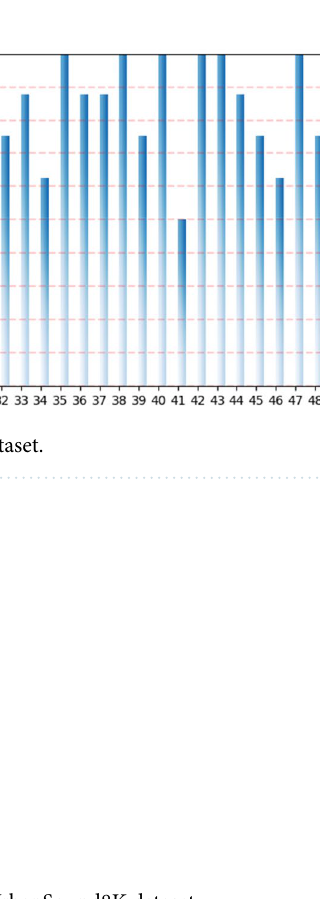
Table 5. Comparison of RACNN and state-of-the-art methods on UrbanSound8K dataset.